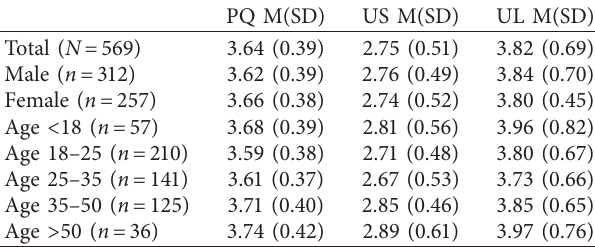
Table 4: Means and SDs of model